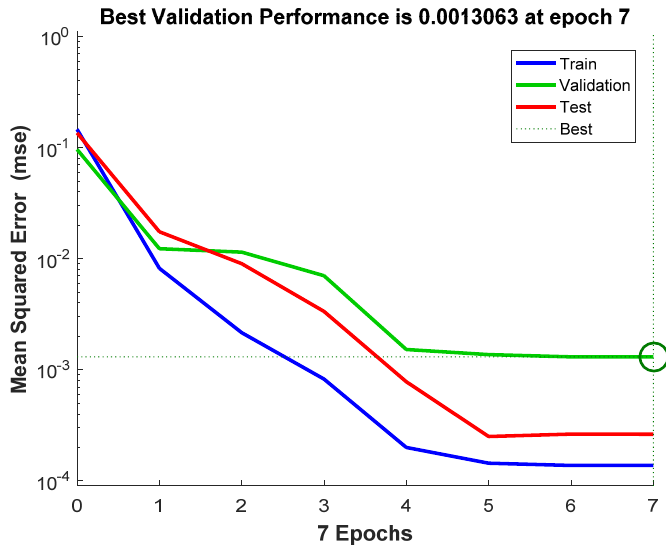
Figure 6. The mean square error plot.